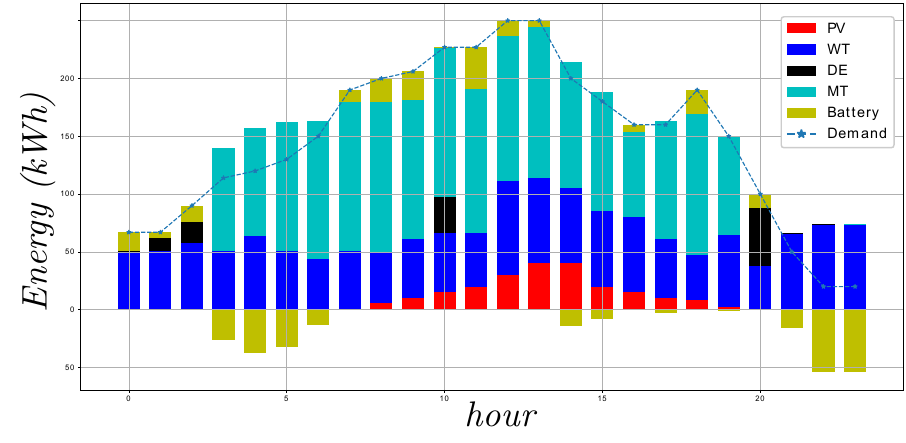
Figure 12. UC and ED solution for Case Study 3.